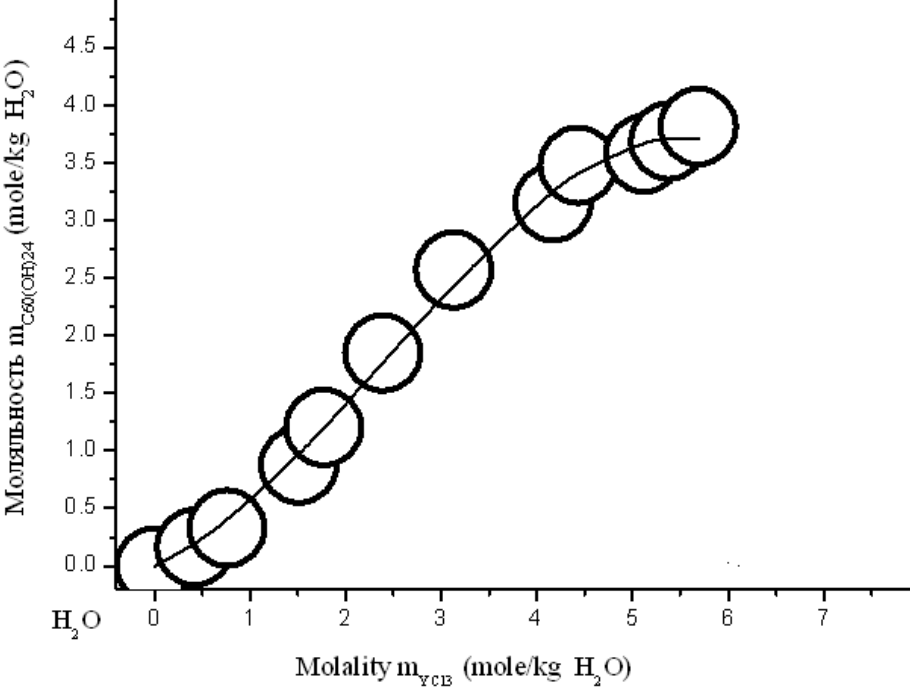
Figure 18. Branch of crystallization C 60 (OH) 24 *18H 2 O in the diagram of solubility in ternary system C 60 (OH) 24 —YCl 3 —H 2 O at 25 ◦ C (convex-conxave σ − id line—calculation according to modified three-parameter Sechenov equation—SEM-3 (15)). Curiously, no two-parameter model is capable of such a description (see Table